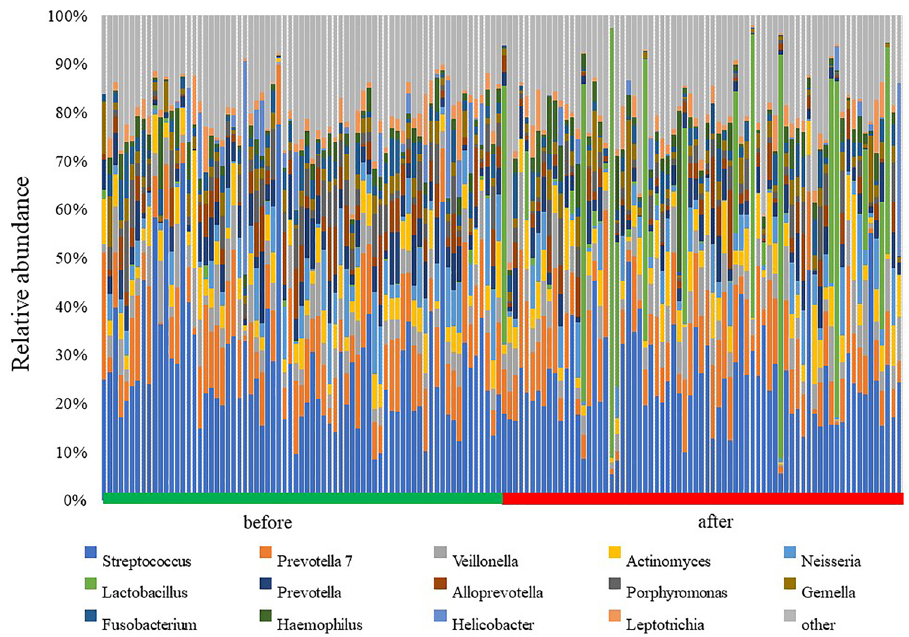
Figure 3. Taxonomic composition of gastric microbiota before and after distal gastrectomy (DG) at the genus level in Billroth I (BI) and Roux-en-Y (RY) reconstructions. Bar plot of the 14 most abundant genera in patients before and after DG. The most abundant genera before and after DG were Streptococcus , Prevotella 7 , Lactobacillus , Veillonella , and Actinomyces